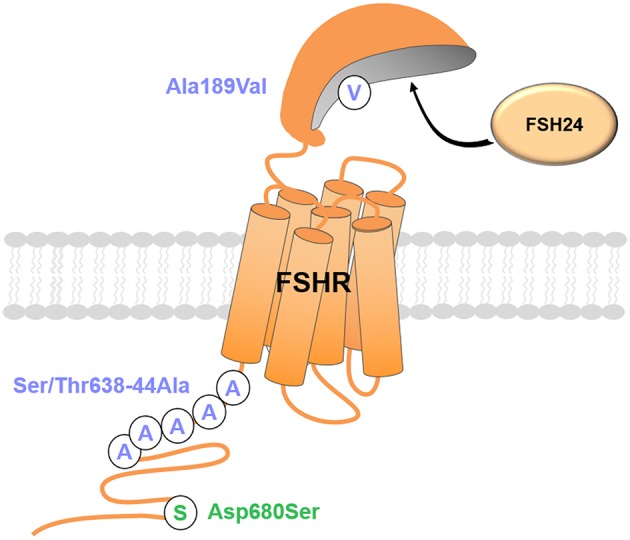
Mutation-induced receptor bias at the FSHR. Mutations can lead to biased signal transduction at the FSHR upon exposure to fully glycosylated FSH (FSH24). Green, Gs-biased mutants; purple, β-arrestin-biased mutant.